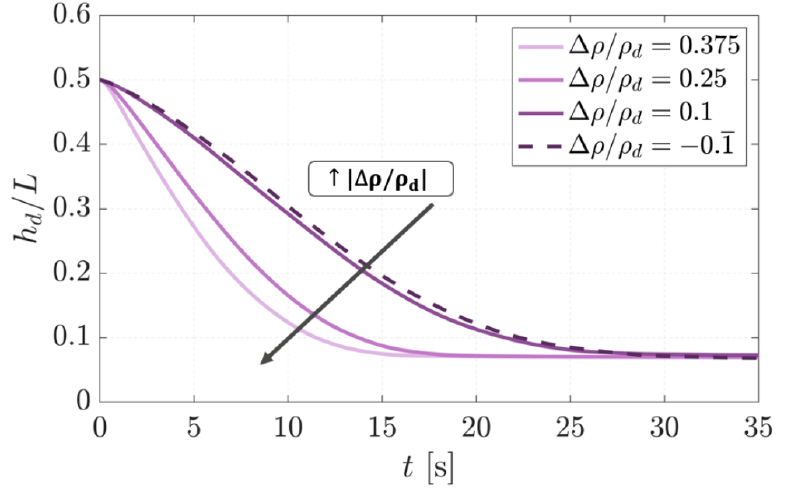
Figure 7. Segregation progress measured by the height of the center of mass of the dispersed phase. Note that the curve of ∆ ρ / ρ d = − 0.1 is mirrored at h d / L = 0.5, to allow for a better